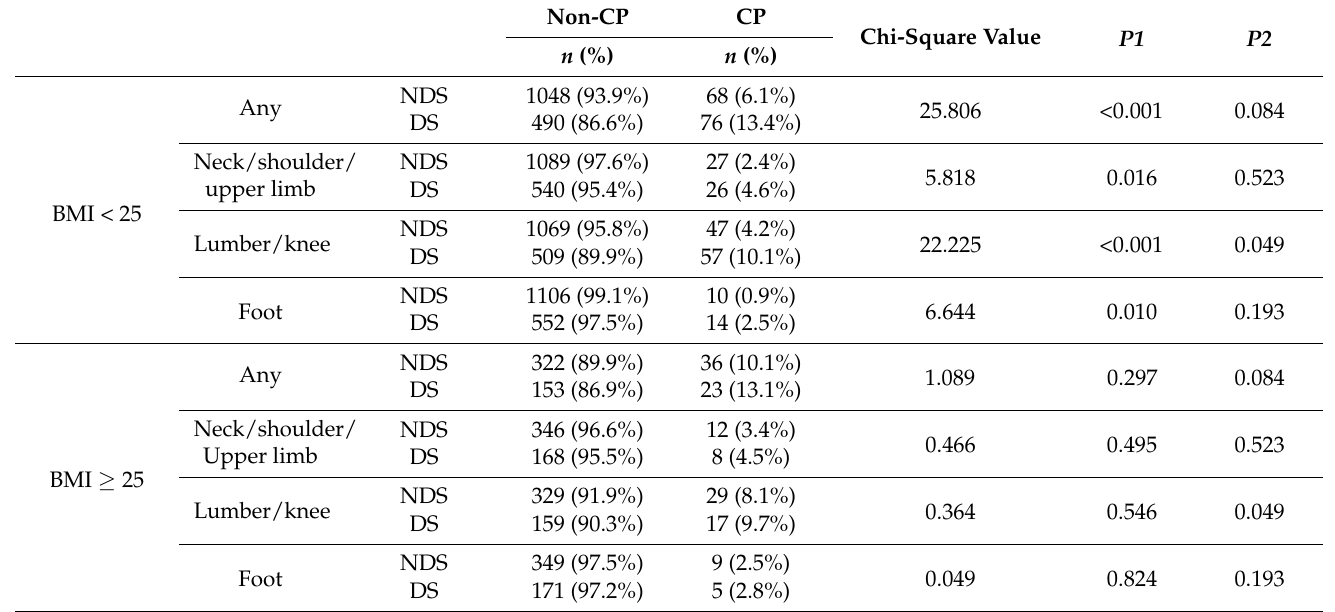
Table 4. Breslow–Day test on CP location and DS stratified by